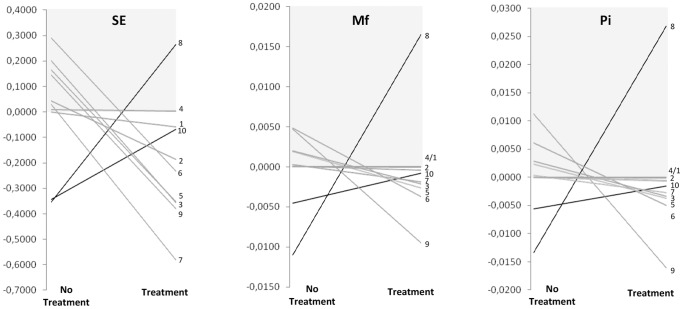
Patterns of QA complexity in the period without and with treatment, according to Sn, Mf, and Pi.The vertical axis represents differences between the complexity parameter (Sn, Mf or Pi) during the time period indicated in horizontal axis, No Treatment (TF-B) and Treatment (TNR-TF). The grey areas highlight positive values and represent an increase in HBV QA complexity.